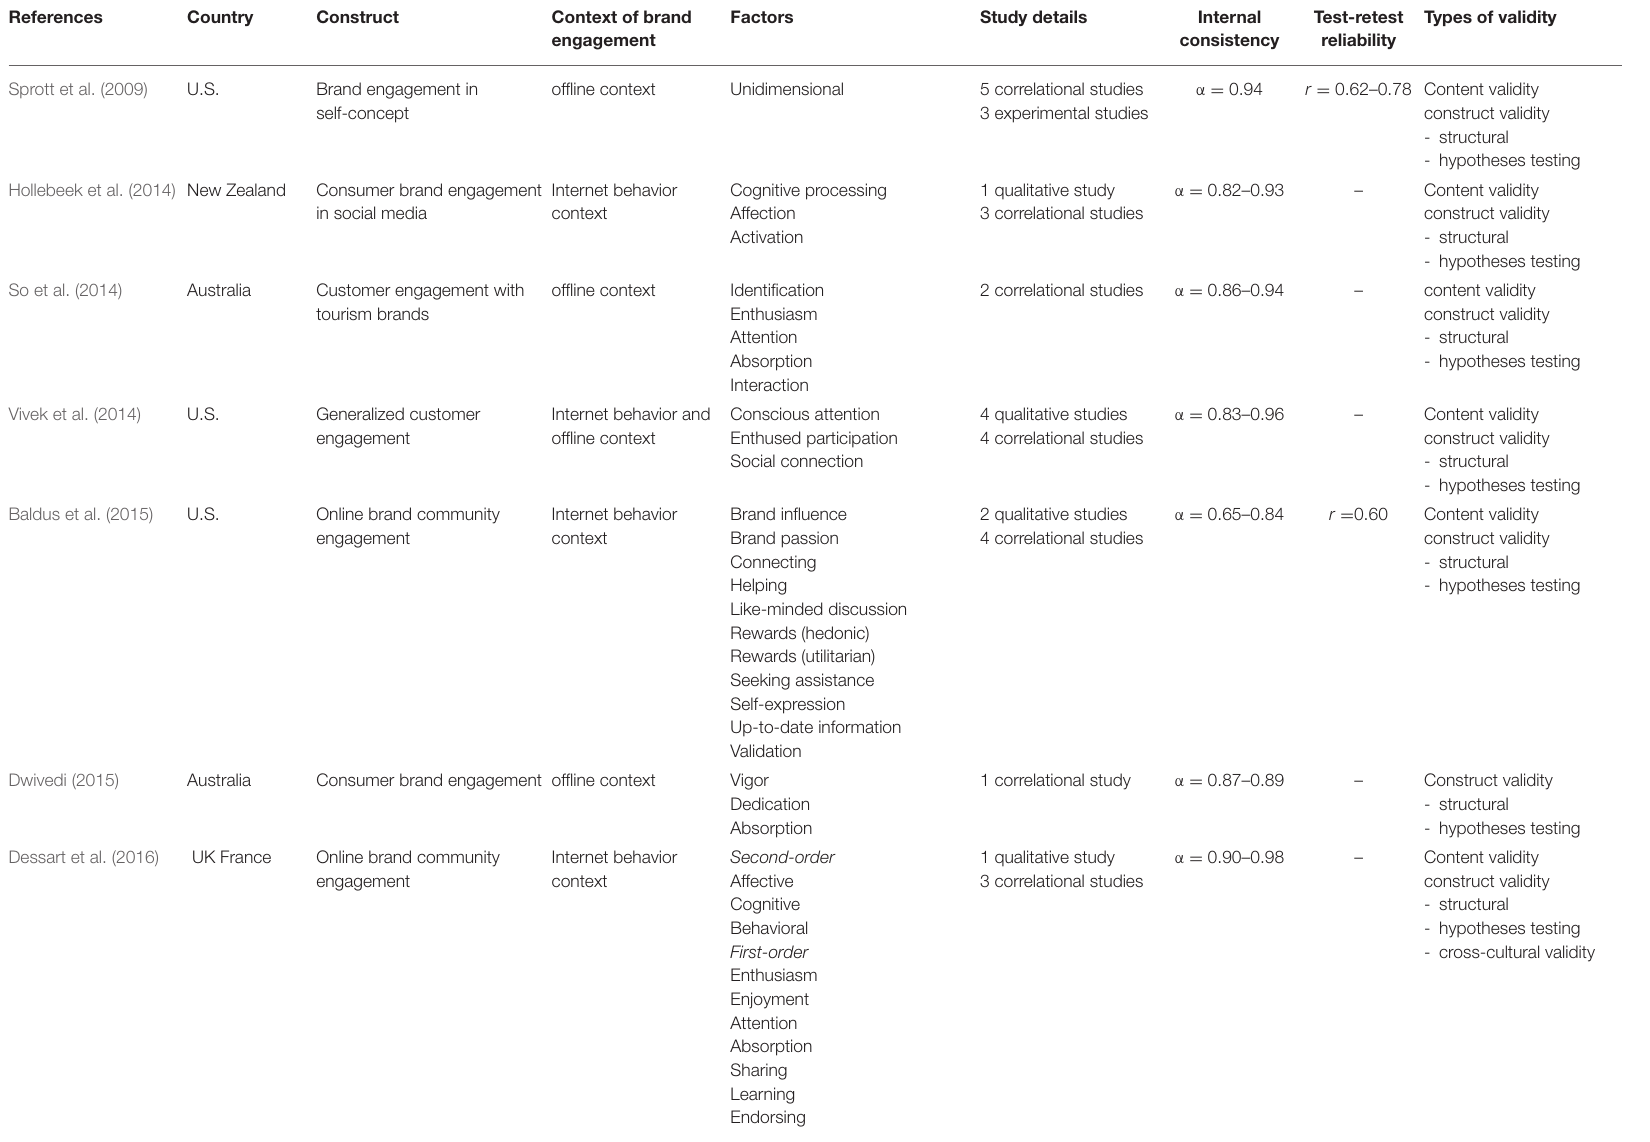
TABLE 1 | Scales developed to measure brand